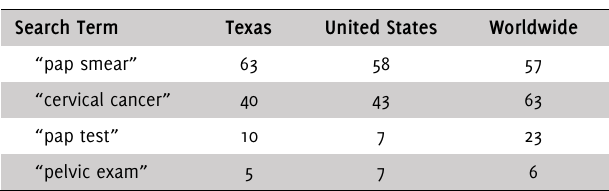
Table 2 . “Interest Over Time” Values by Region for Four Different Search Terms Related to Cervical Cancer Screening using Google Trends Data Specific to the Week of June 7 – June 13, 2020, Peak Popularity for a Given Search is